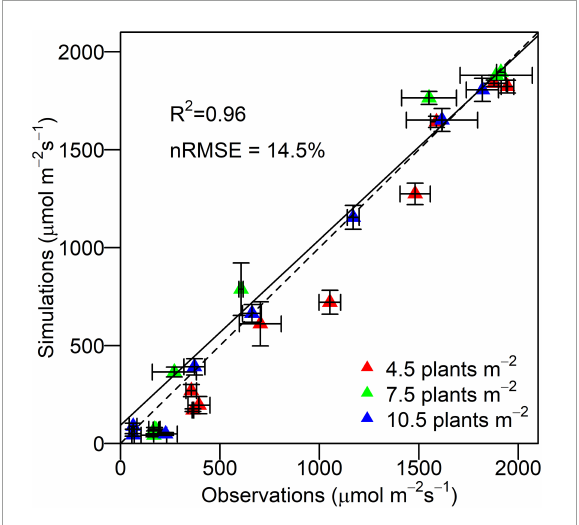
FIGURE4 Observations of irradiant PAR by quantum sensors and simulations of irradiant PAR by virtual line sensors in the 3D model at different canopy depths at the density of 4.5, 7.5, and 10.5 plants m - 2 for XY335. Error bars indicate the SE. The dashed line is the 1:1 line. The solid line is the regression line.